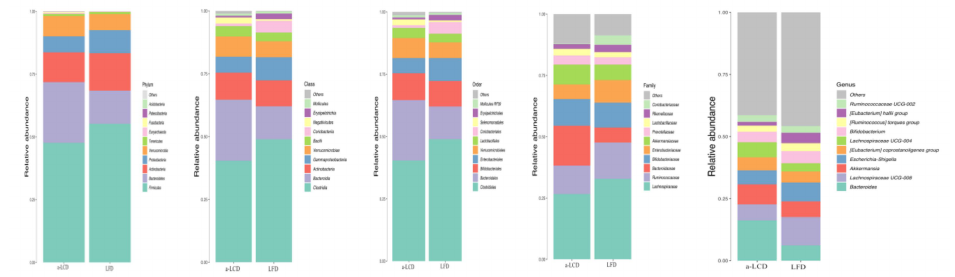
Figure 4. The comparison of the overall microbial composition between the two groups at the baseline. Only taxonomic groups 1% or greater are shown.